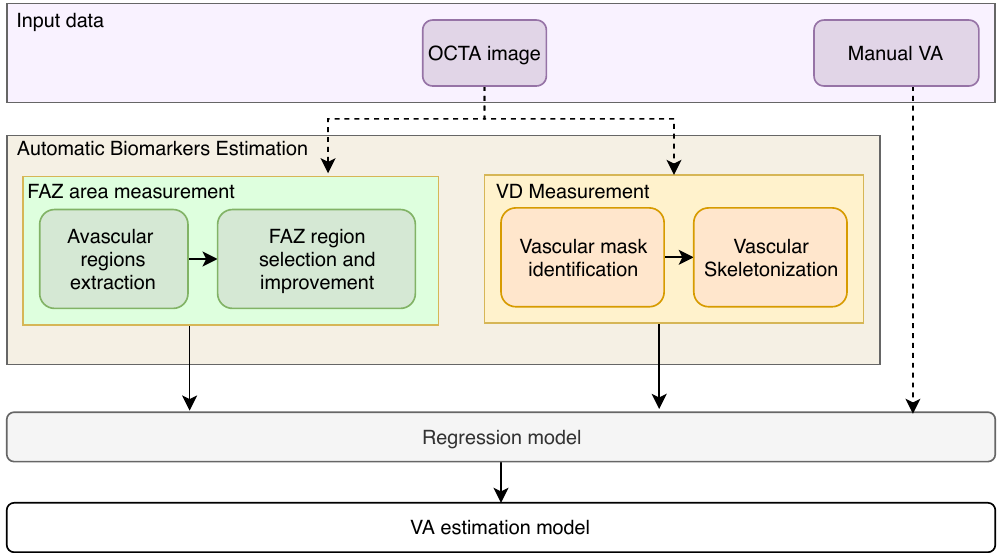
Figure 1. Main steps of the proposed methodology for the Visual Acuity (VA)